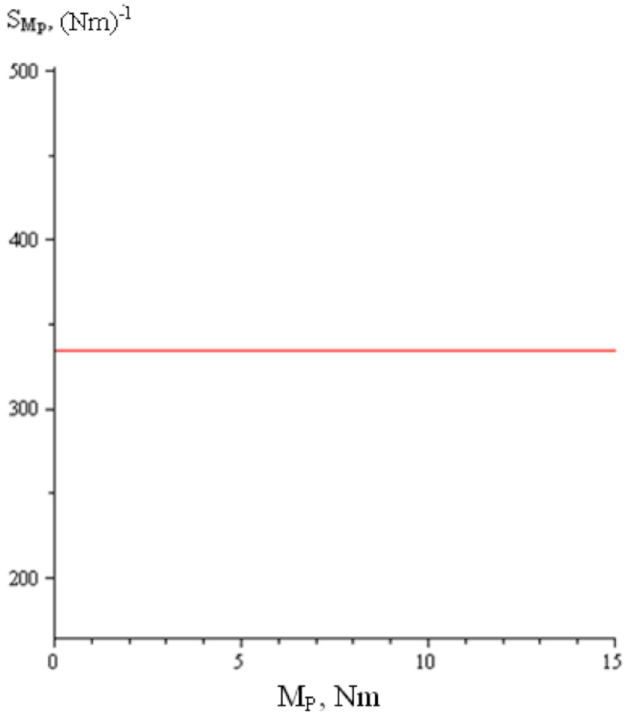
Fig. 3. MM sensitivity.